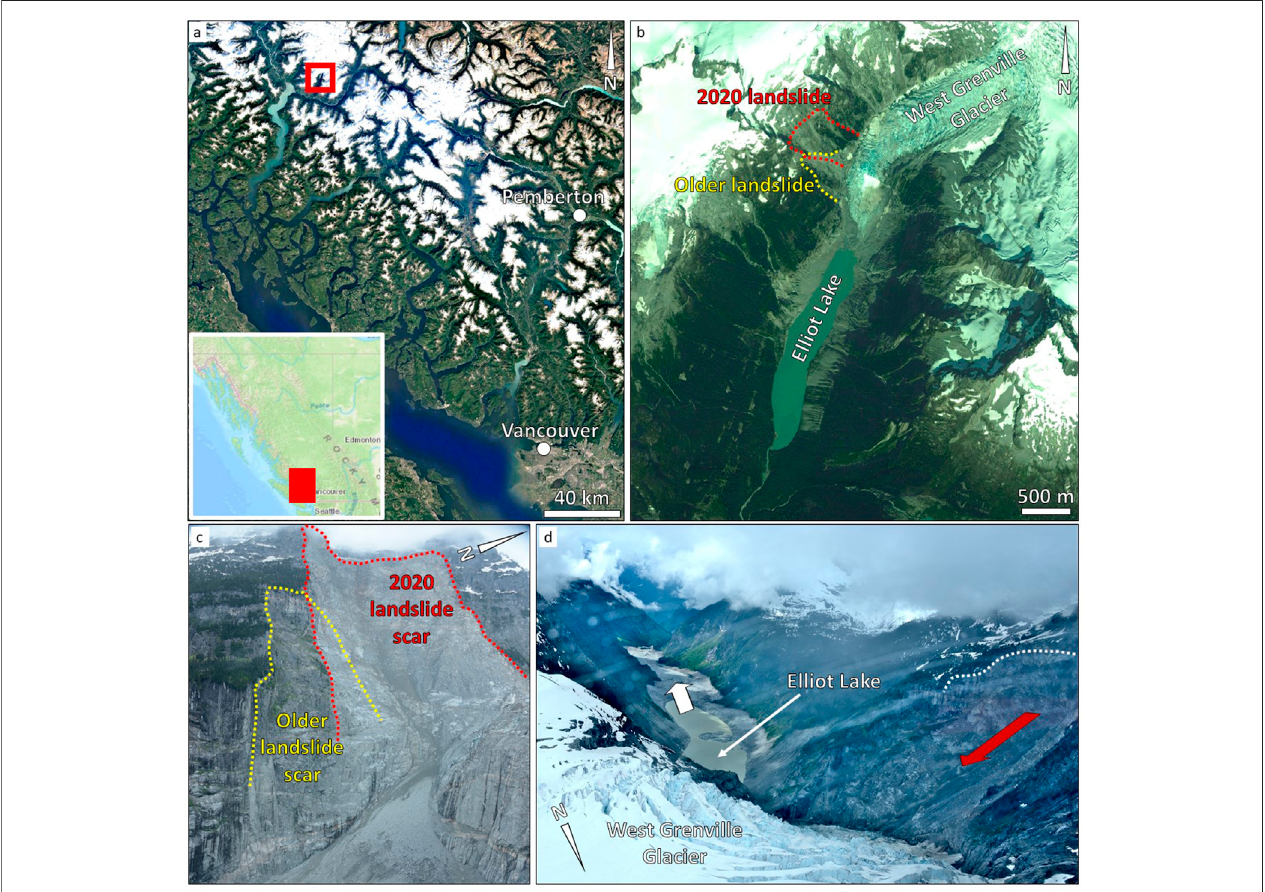
FIGURE 1 | Geographic overview of the study site. (A) location of the Elliot Creek landslide in southwestern British Columbia. (B) 2012 satellite imagery (Maxar Technologies imagery from Google Earth) showing the area affected by the landslide. The red, dashed line outlines the volume failed in 2020. The yellow, dashed line shows the inferred boundaries of the older landslide of unknown age. Note the Elliot Lake, at the valley bottom, formed after the retreat of the West Grenville Glacier. (C) oblique viewofthelandslidearea, showing theboundaryofthe2020landslideand the inferred boundaryoftheolderevent(photo June2021). (D) View from north of the Elliot Creek after the occurrence of the landslide, showing the effects of the landslide-generated wave on the valley slopes. The white, dashed curve outlines the landslide crest. The red and white arrows show the movement directions of the landslide volume and the landslide-generated wave, respectively (photo June 2021).